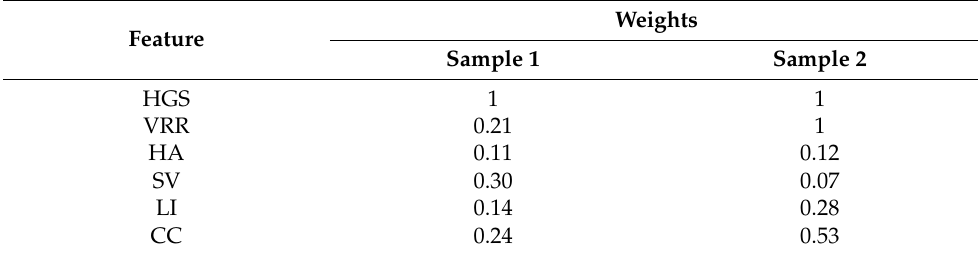
Table 3. An example of entropy weight and final weight calculation of two samples from the Sanmenxia 220 kV data (Dataset 1). Sample 1 is of the PTLs which are away from pylons. Sample 2 is of the PTLs close to